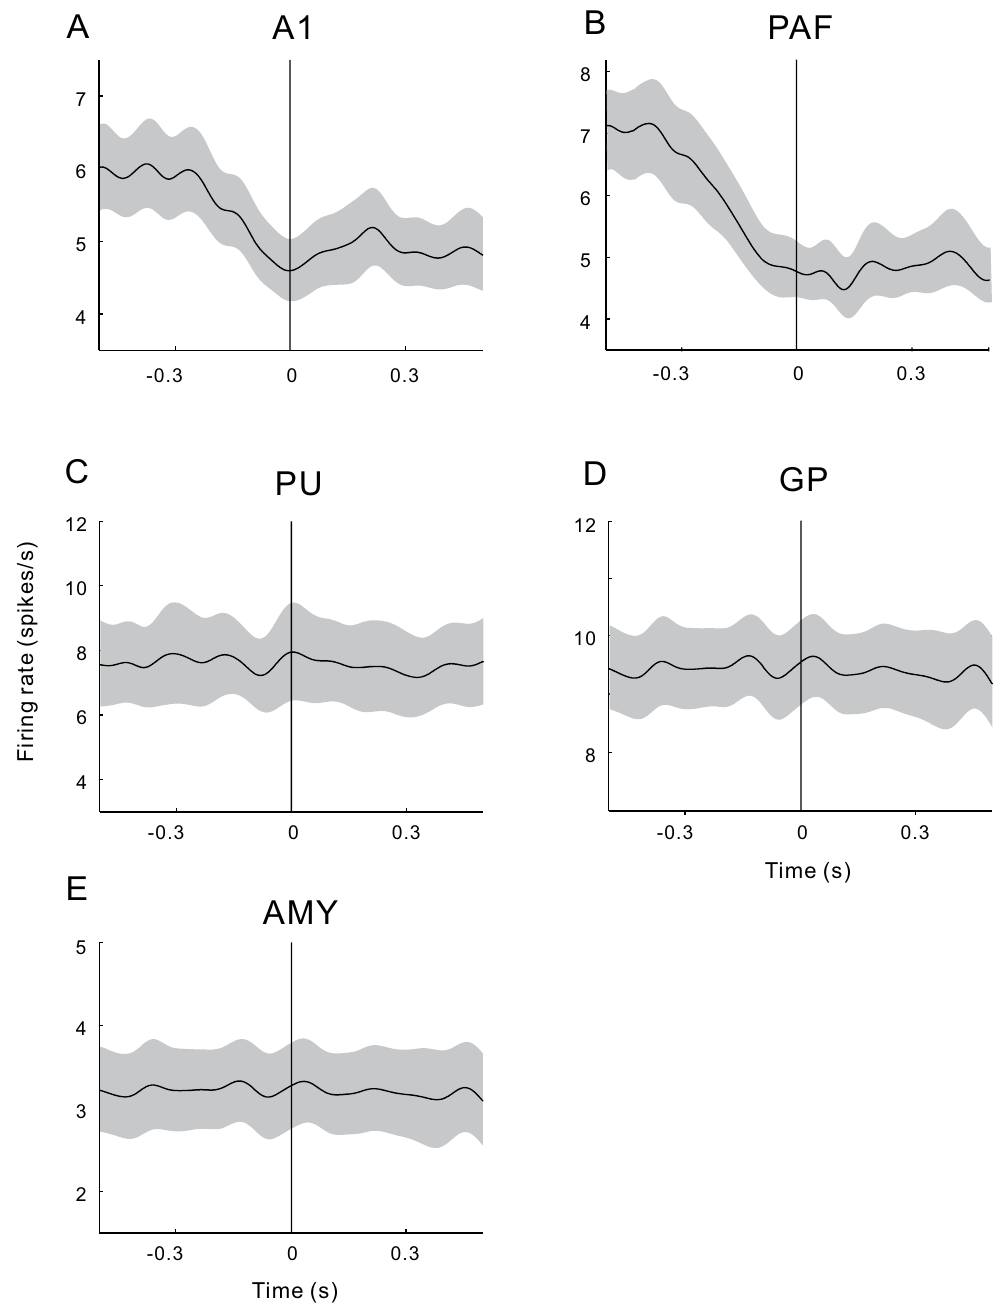
Figure 10. Peri-licking peri-stimulus time histograms (PSTHs) averaged across the units in different brain areas. Shaded area represents the standard error. Vertical line represents the time of the first